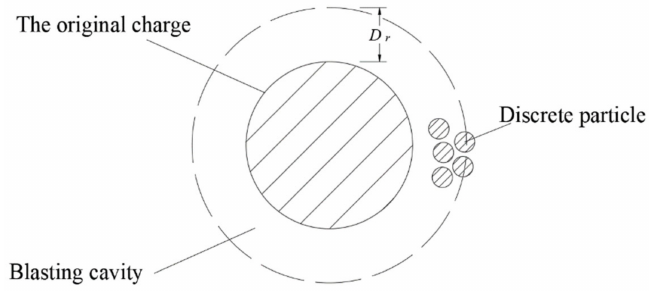
Figure 2. Schematic diagram of blasting